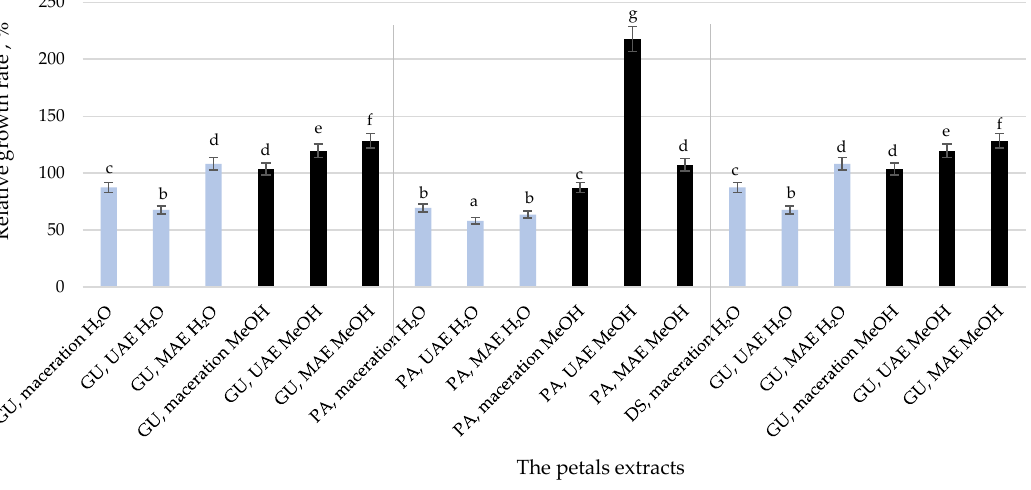
Figure 2. Relative growth rate of the HaCaT cell line in the presence of P. tenuifolia extracts. The letters represent statistical significance: a p ≤ 0.05; b and c, p ≤ 0.001; d and e, p ≤ 0.0001; e and f, p ≤ 0.00001; g, p ≤ 0.000001. Table 5. Effects of the P. tenuifolia extracts on migration capacity of HaCaT cells (wound healing). Origin of Plant